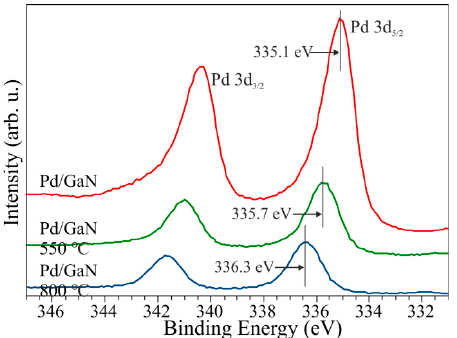
Figure 27. Pd ‐ 3d spectra for Pd on GaN(0001) before and after heating at 550 and 800 °C. Re ‐ Figure 27. Pd-3d spectra for Pd on GaN(0001) before and after heating at 550 and 800 ◦ C. Reprinted printed with permission from [34]. Copyright 2015 Springer Nature. with permission from [34]. Copyright 2015 Springer After heating to a higher temperature, the line shifts to the 19.8 eV position, and its intensity continues to increase. This testifies that the surface of the GaN substrate is ex ‐ posed. This observation is consistent with LEED and STM measurements. After annealing the system at 550 ℃ , a blurry LEED image, corresponding to the GaN(0001) ‐ (1 × 1) struc ‐ ture, starts being visible. Annealing at higher temperatures enhances the intensity of the spots and sharpens the image. STM analyses of the system after annealing at lower tem ‐ peratures indicated an island topography. Islands, varying in diameter and height, were randomly placed on the surface. Additional heating at 800 ℃ caused the population of the islands to decrease, but their diameters and heights increased. UPS spectra made for a bare substrate covered with a thin Pd film, before and after heating at various tempera ‐ tures, are shown in Figure 28a. The VBM for a bare surface lies at 2.8 eV above the E F ; after